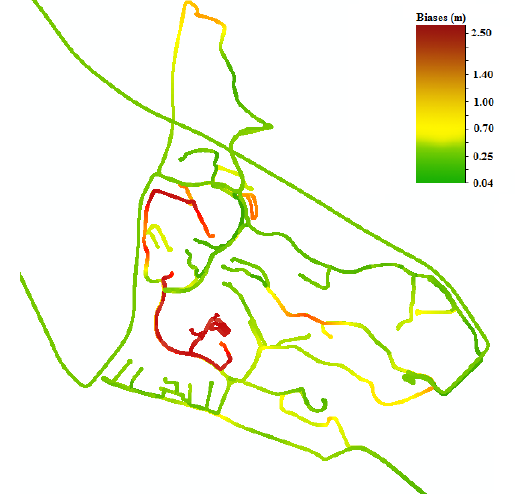
Figure 7. The new trajectory coloured by the magnitude of the sum of X, Y and Z